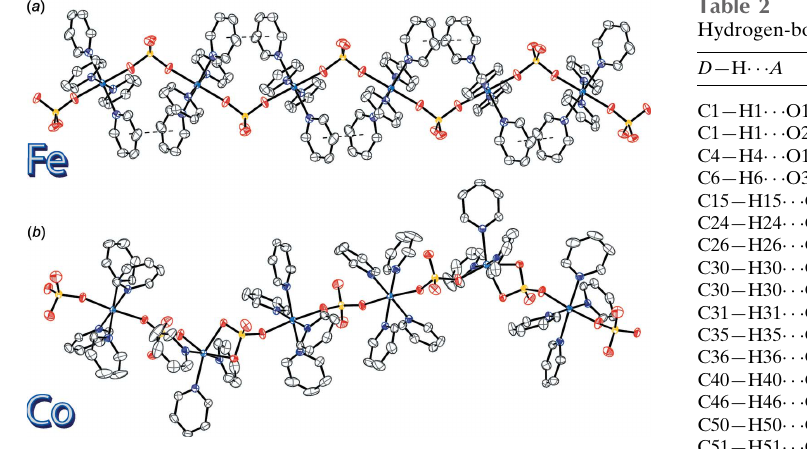
Figure 3 The infinite chains of ( a ) compound ( 1 ) along [100] and ( b ) compound ( 2 ) along [001]. Displacement ellipsoids are drawn at the 50% probability level. H atoms are omitted for clarity. (cid:4) – (cid:4) interactions are shown as dashed lines. 67.08 (1) and 68.07 (1) (cid:2) . Two of the rings are involved in two C—H (cid:3) (cid:3) (cid:3) O interactions each with the sulfate oxygen atoms